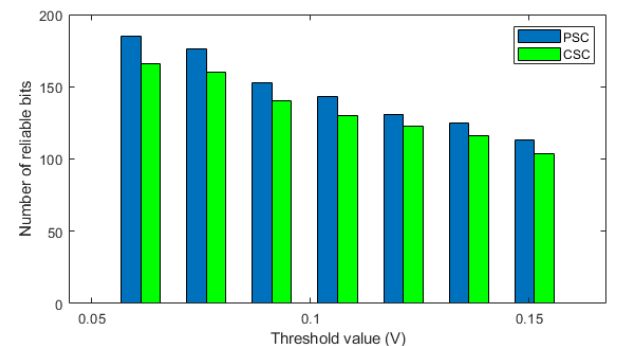
Figure 8. Comparison of generated bits using PSC and CSC for DiffC-PUF data.